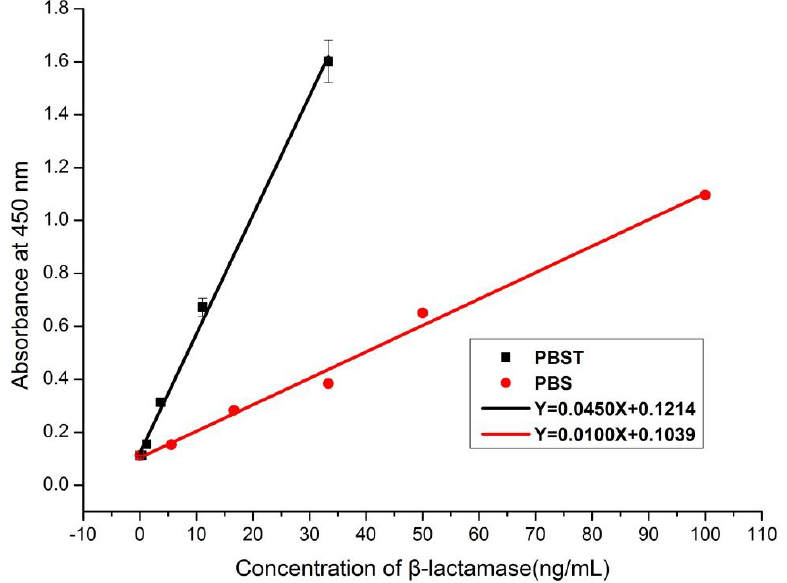
Figure 3. Running curves in PBS and PBS containing 0.1% Tween.